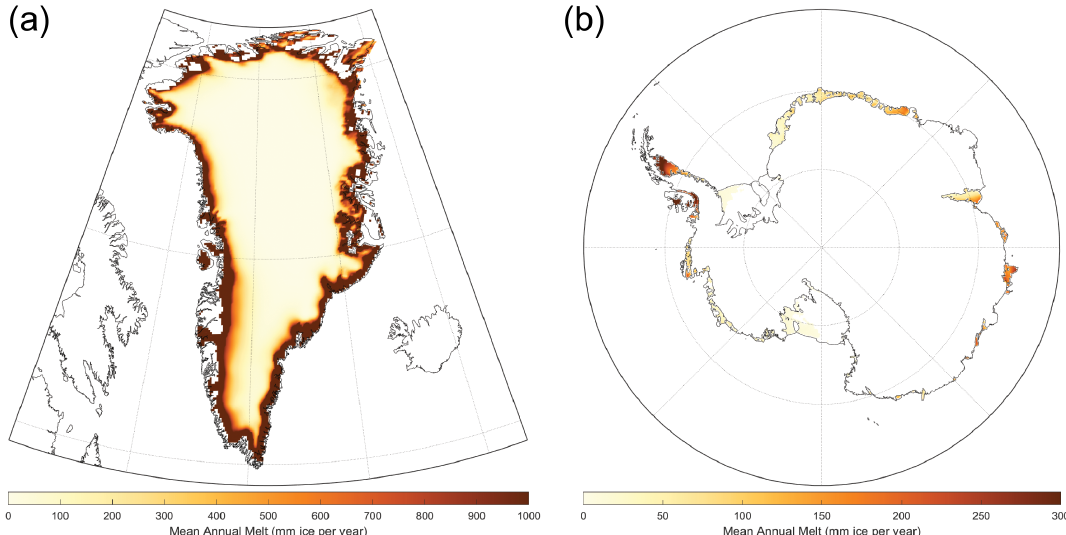
Figure 9. Mean annual meltwater fluxes for the (a) Greenland and (b) Antarctic ice sheets based on a degree-day approach. Note the differences in color scale for Greenland and